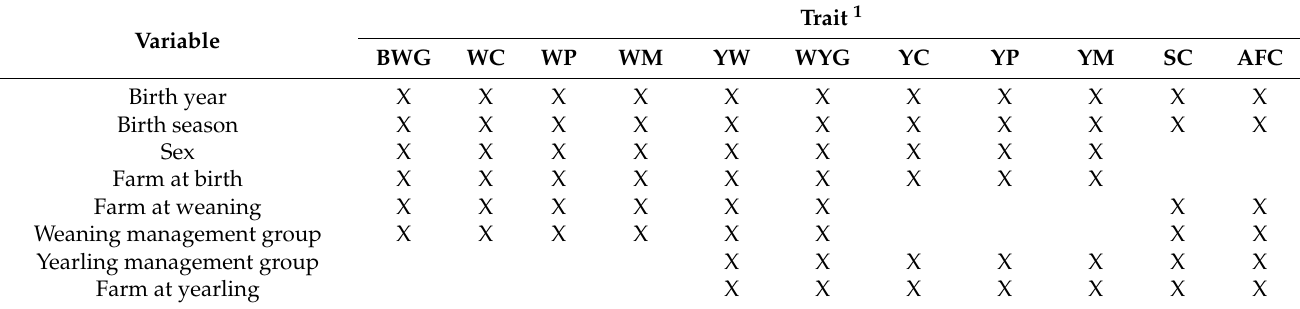
Table 2. Variables included in the definition of contemporary